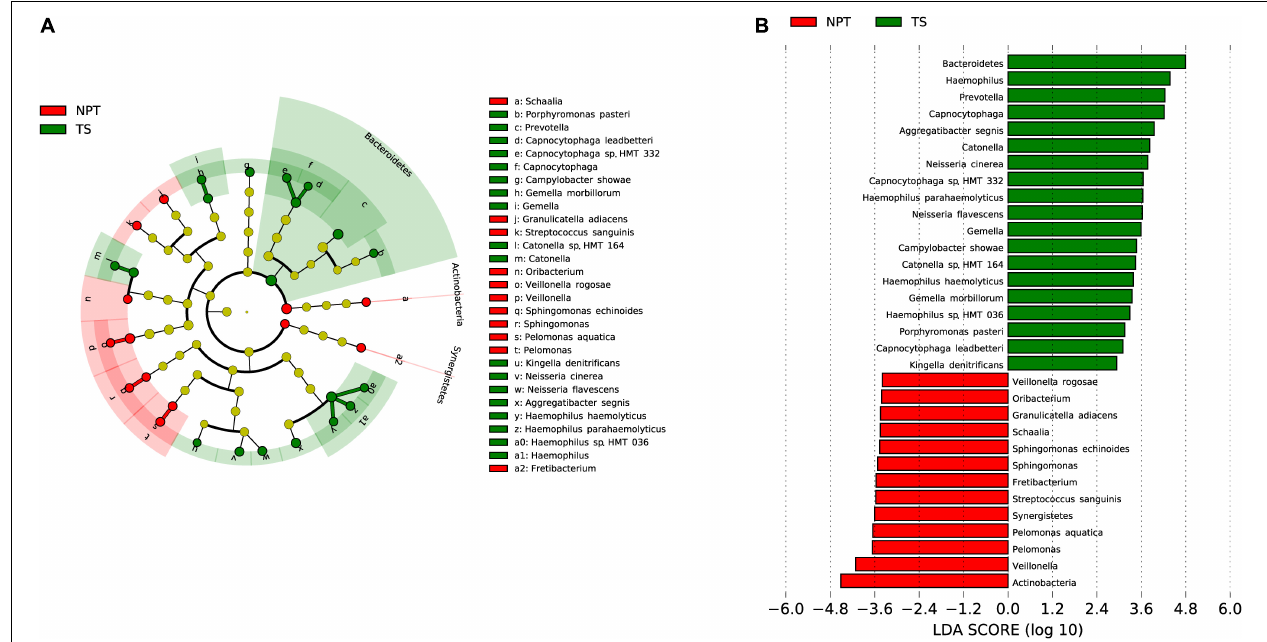
FIGURE 5 | Comparative taxonomic profile of NPT and TS groups. (A) The cladogram showed differently enriched taxa. (B) LDA scores computed for differentially abundant taxa between TT and TS groups (Log10 LDA scores > 2). The phyla, genera, and species with significant richness differences (FDR < 0.05) between the two groups are